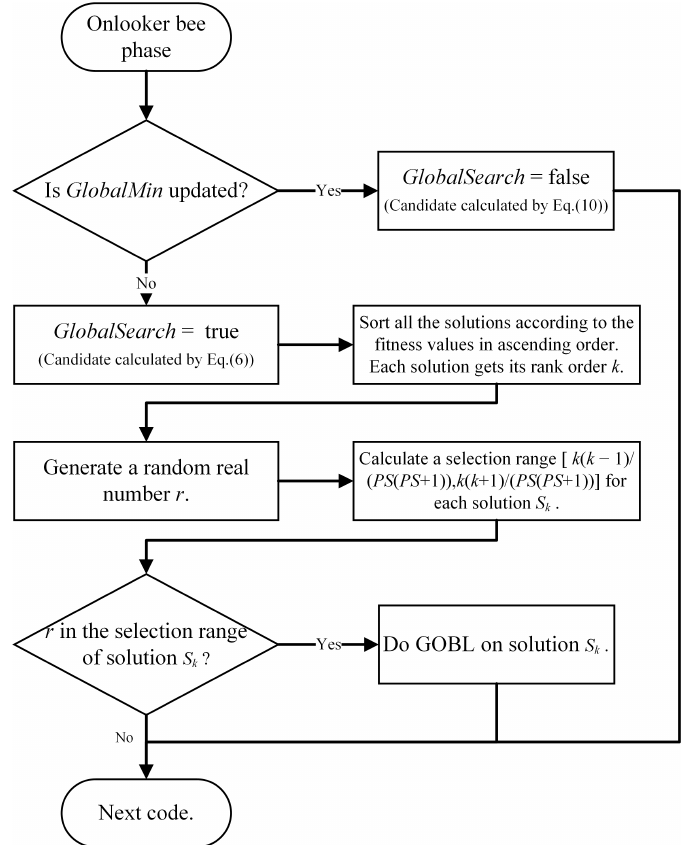
Figure 2. Flow Chart of Dynamic Search Update